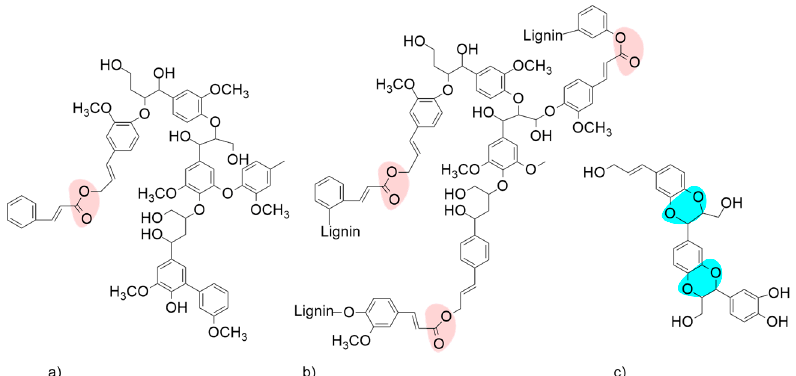
Figure 3. Representation of lignin polymer structures: ( a ) Wild-type lignin; ( b ) engineered lignin with high levels of ferulic acid; ( c ) recently discovered C-lignin. Pink color marks indicate ester linkages. Blue color marks indicate ether linkages. Adapted with permission from [27]. Copyright 2016, Elsevier.